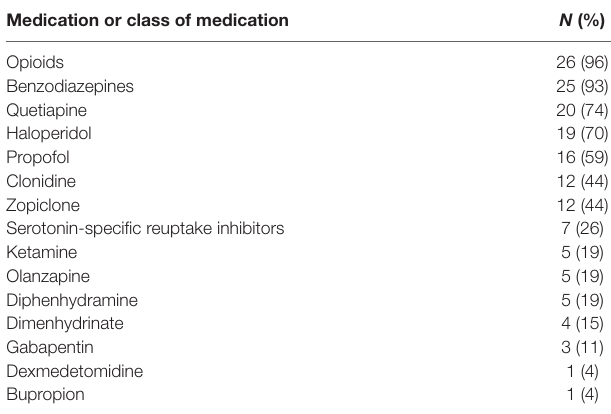
TablE 2 | analgesics, sedatives, antipsychotics and other psychoactive medications used.